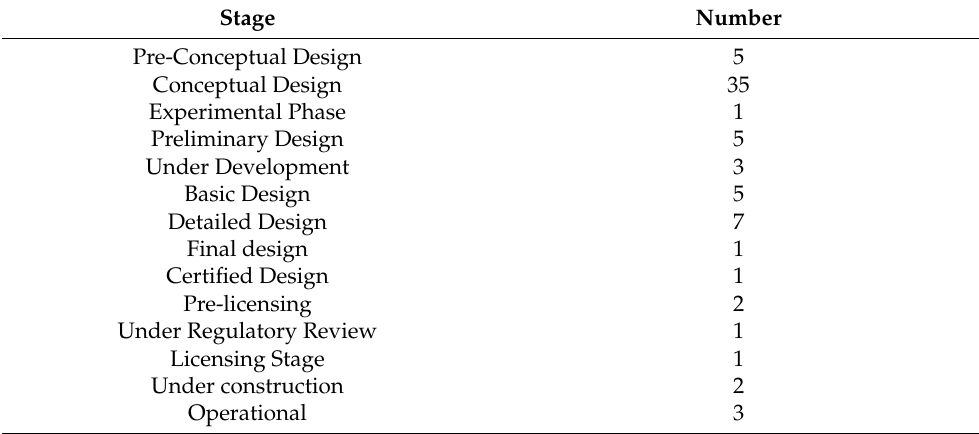
Table 2. Status of SMR